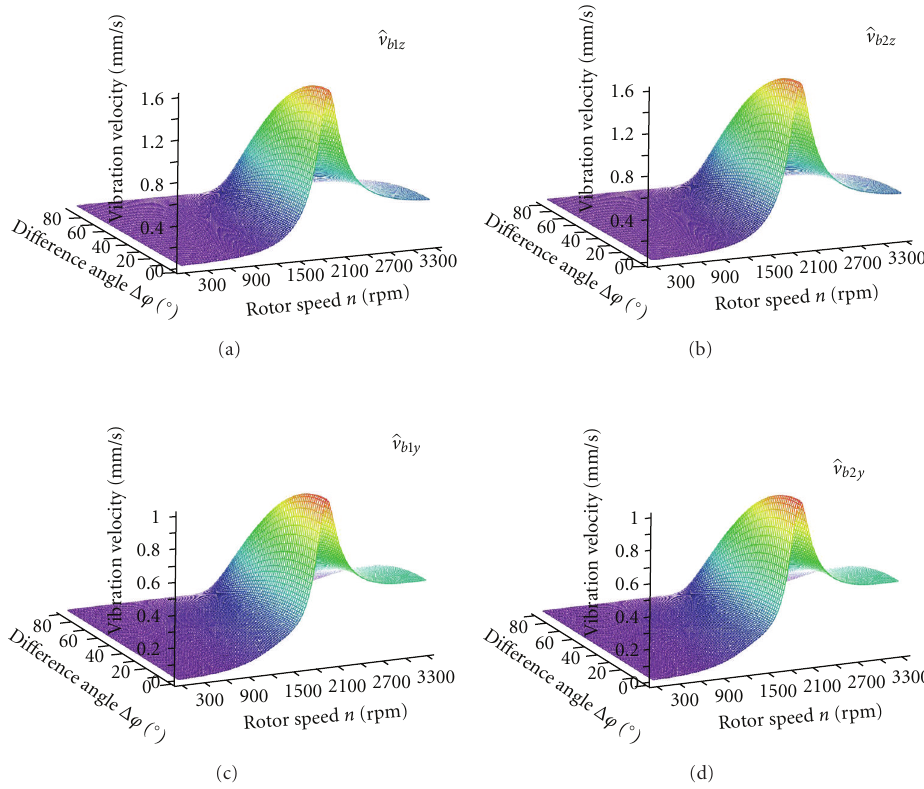
Figure 15: Bearing housing velocities in (a) vertical direction at bearing (1), (b) vertical direction at bearing (2), (c) horizontal direction at bearing (1), and (d) horizontal direction at bearing (2), depending on the rotor speed n and on the di ff erence angle Δ ϕ